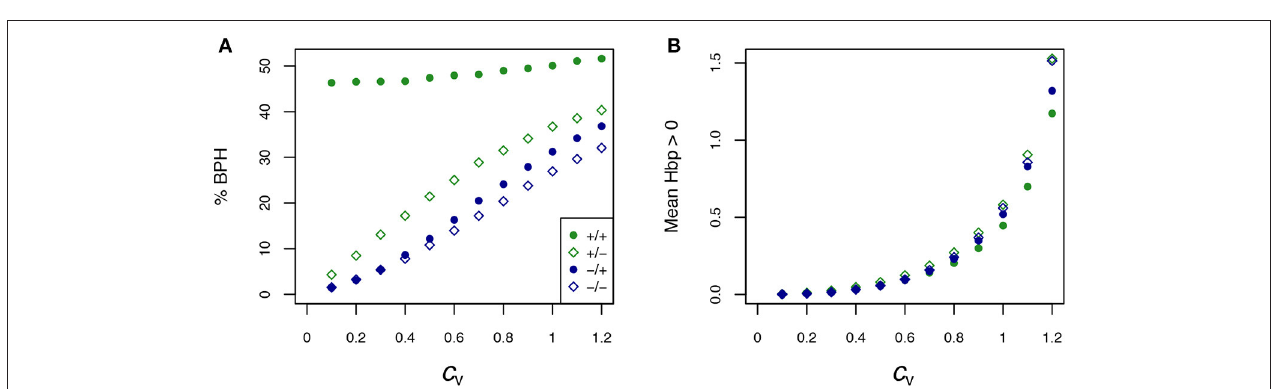
0.33, p < 0.01). (C) Relationship between H BP and H reg , the = − 0.46, p < 0.001). (D) = 0.77, p < 2.5.10 − 13 ). Red points correspond to =